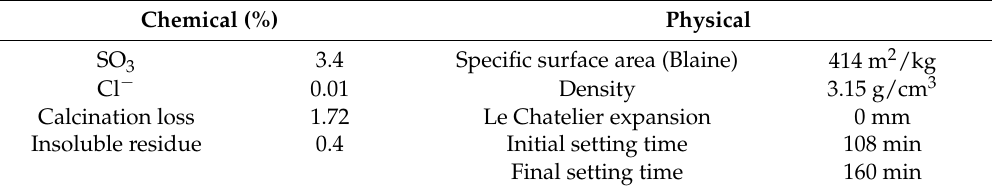
Table 1. Main properties of Portland